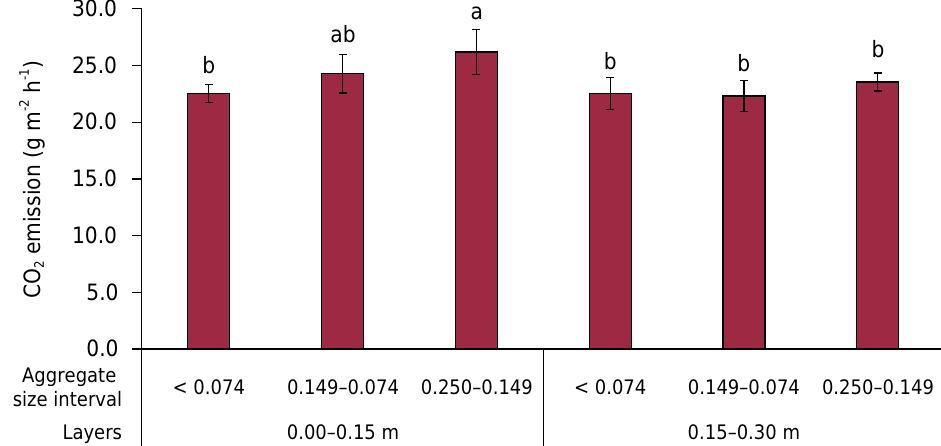
Figure 5. Accumulated emission of CO 2 by layer and aggregates size of a calcareous soil in the Comarca Lagunera,